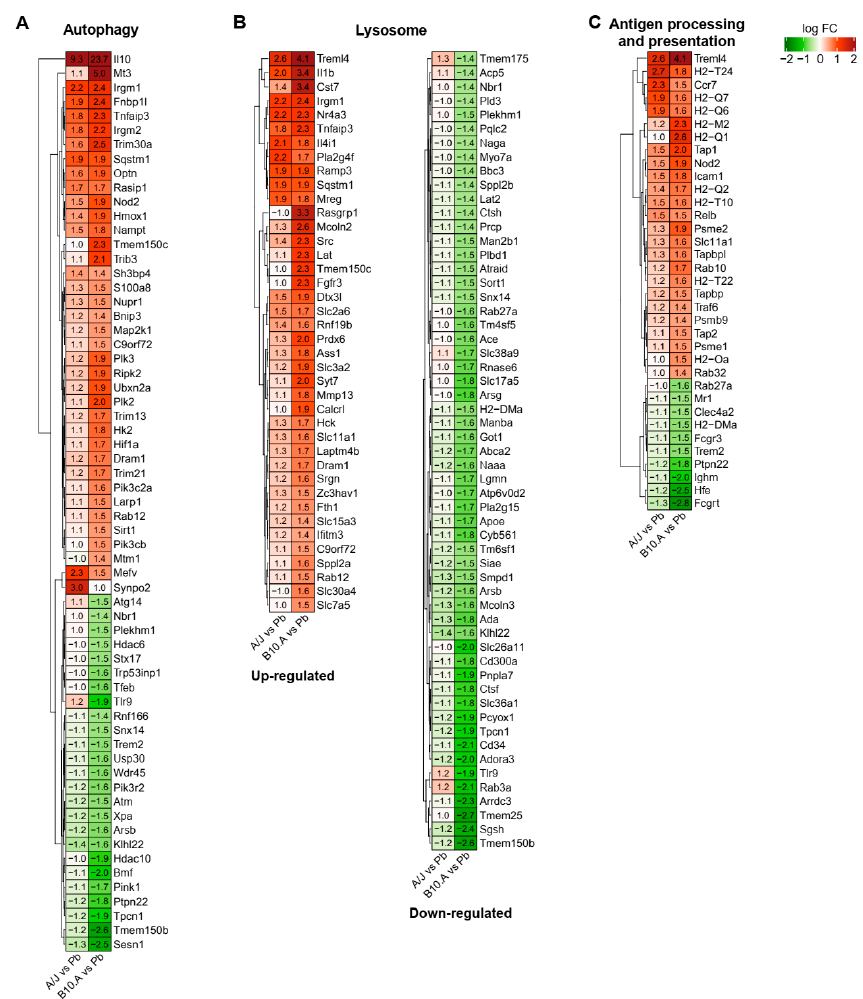
Figure 6. Heat map of differently expressed antigen presentation, autophagy and lysosome function genes (Gene Ontology terms) between BMDCs from resistant (A/J) and susceptible (B10.A) mouse strains upon infection with P. brasiliensis . ( A – C ) The values in heatmaps represent the fold change for each gene. DEGs: adjusted p -value < 0.05, and fold change ≥ ± 1.4.